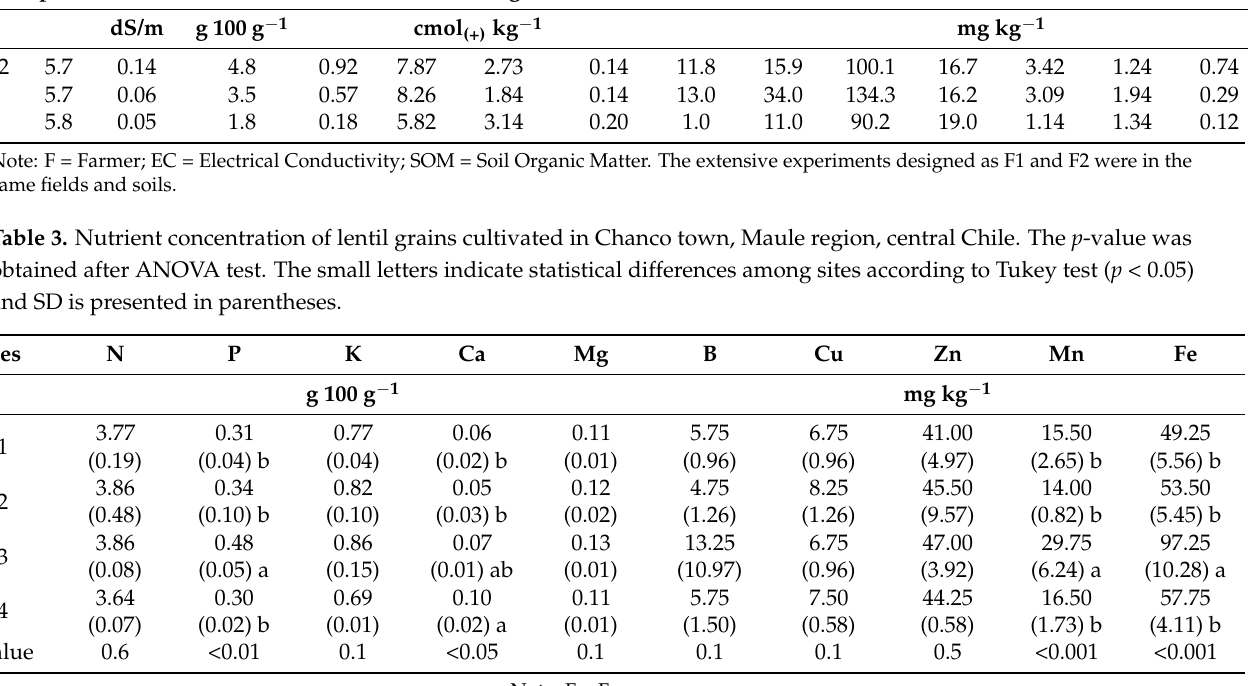
Table 2. Chemical soil analyses of the fields cultivated with lentils during the 2019–2020 season in the town of Chanco, Maule region, Central Chile. pH w